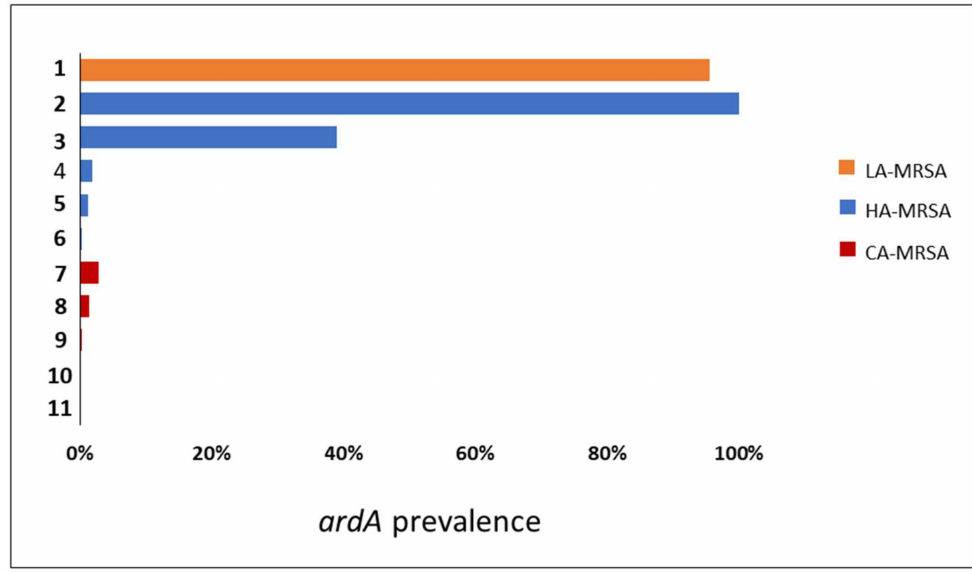
Figure 4. Assessment of ardA -H1 and ardA -H2 in the S. aureus local database composed of genomes that display MLST clonal complexes (CCs) commonly found among hospital-associated MRSA ( n = 3052); genomes from CCs typically found in CA-MRSA ( n = 2384) and genomes from CCs typically found in LA-MRSA ( n = 780). These genomes were related to the following S.